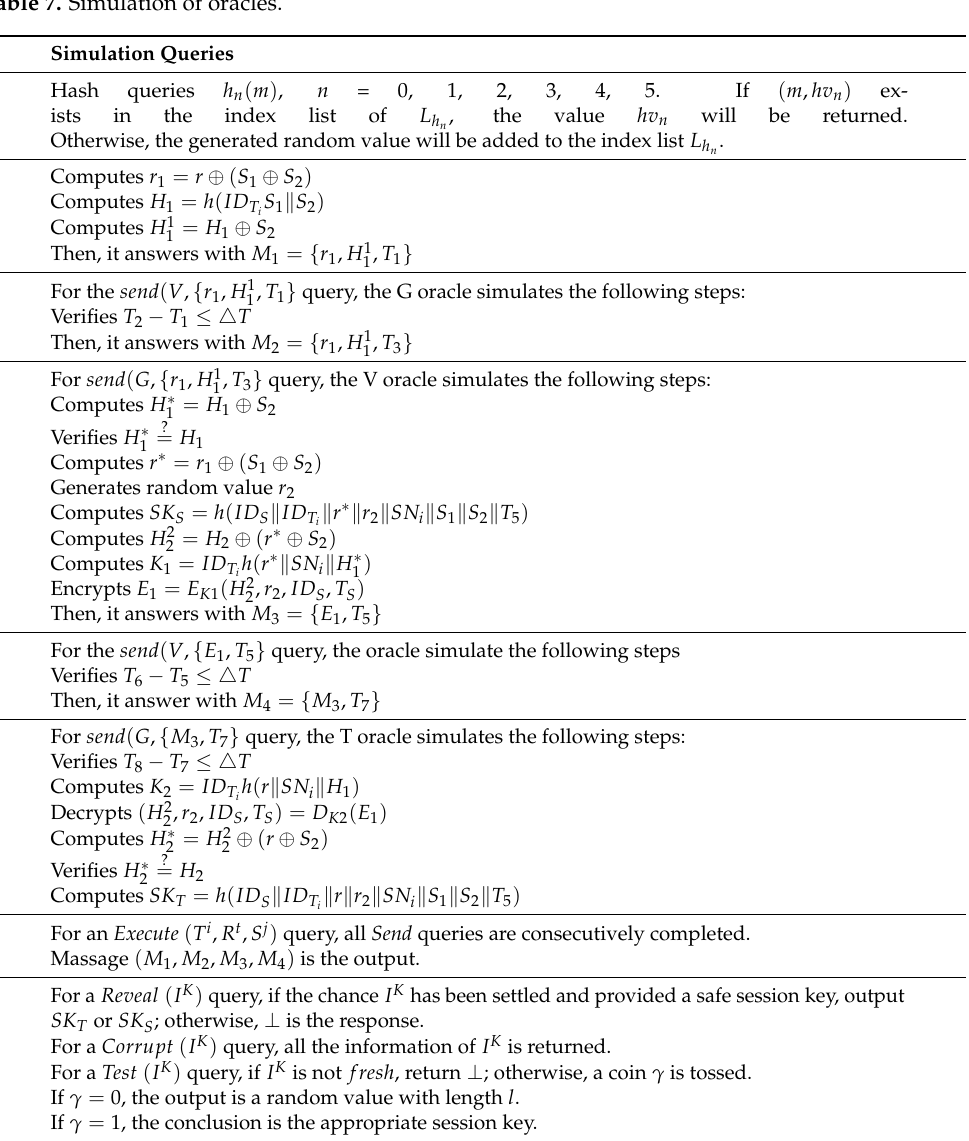
Table 7. Simulation of